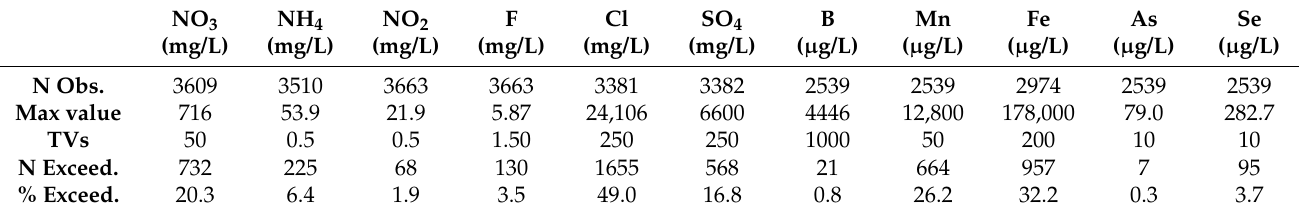
Table 4. Statistics and exceedances of the main inorganic parameters compared to the corresponding TVs. NO 3